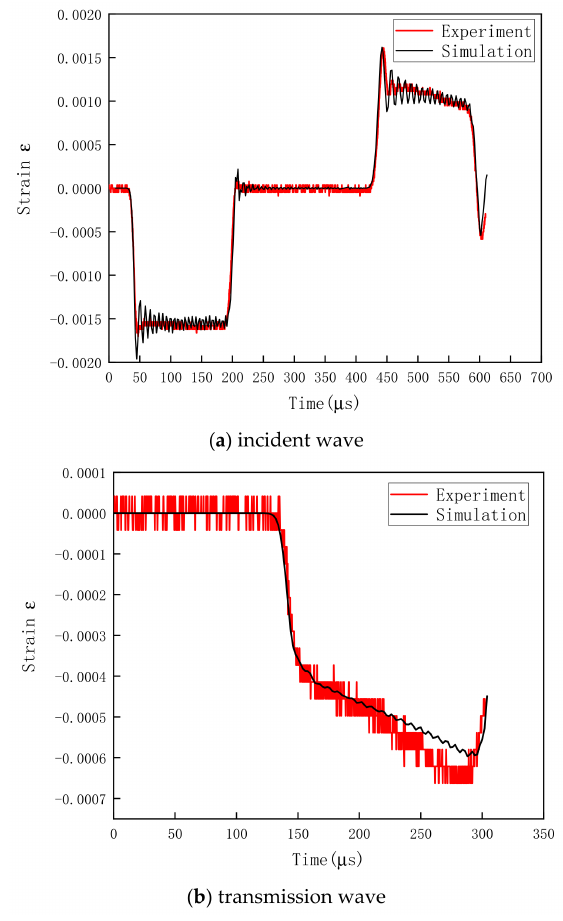
Figure 15. Comparison between strain waveforms generated during test and